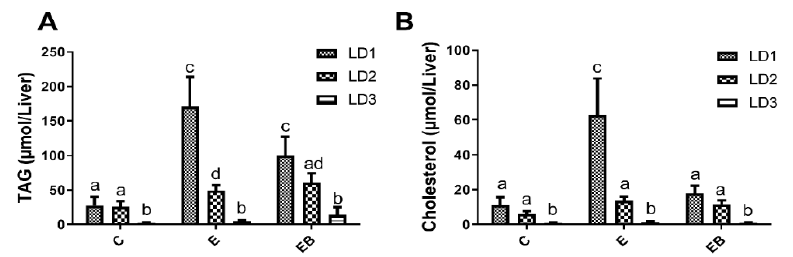
Figure 3. ( A ) Triacylglycerol (TAG) and ( B ) total cholesterol levels in different fractions of liver LDs (LD1-LD3) of rats fed (C), ethanol (E), or betaine-supplemented ethanol (EB) diet. Data are presented as the mean ± SEM ( n = 8); values not sharing a common letter significantly differ from each other at p ≤ 0.05.